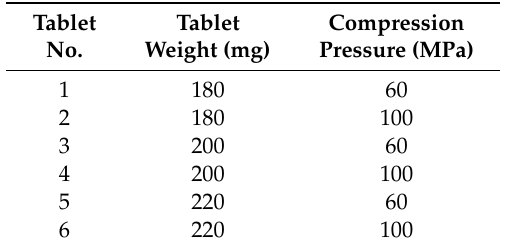
Table 3. Variations in the